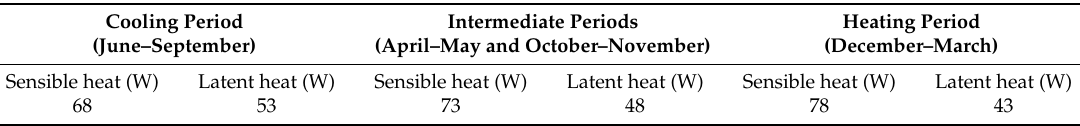
Table 6. Heat generation from a human body in an